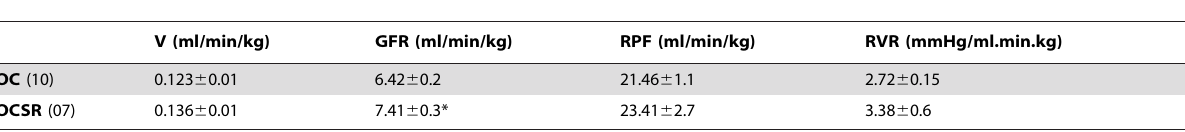
Table 1. Renal function parameters in the studied groups.